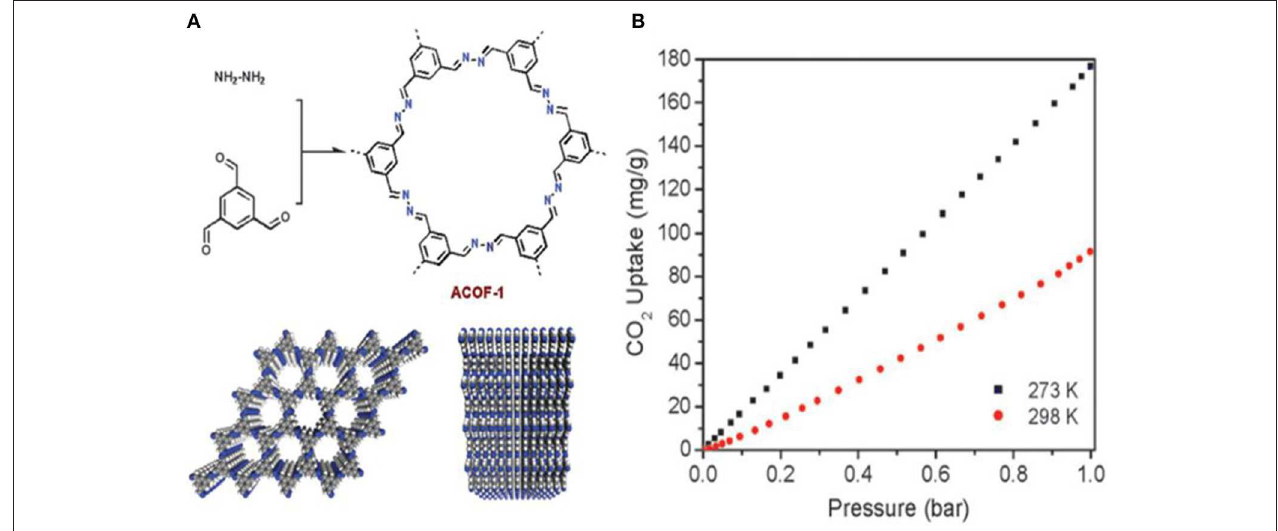
FIGURE 3 | (A) Structure of ACOF-1 and (B) CO 2 adsorption isotherms of COF-JLU2 measured up to 1 bar at both 273 and 298K. Reprinted with permission © The Royal Society of Chemistry